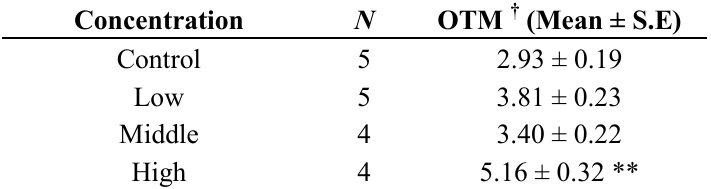
Table 2. Quantitative analysis of Sprague Dawley rat lung cell DNA damage after subchronic exposure to silver nanoparticles using single cell gel electrophoresis (Comet